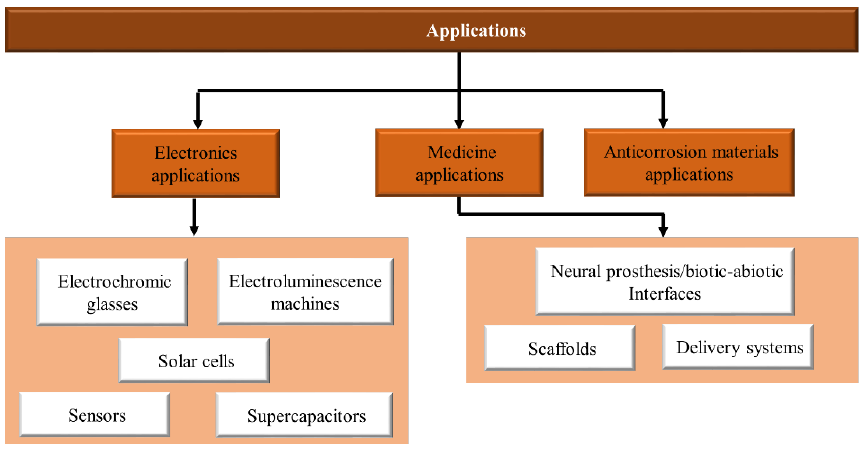
Figure 21. Application of PANI.